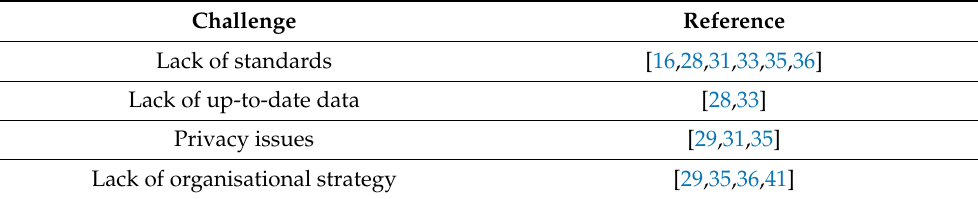
Table 3. Challenges of BIM-based DT creation and